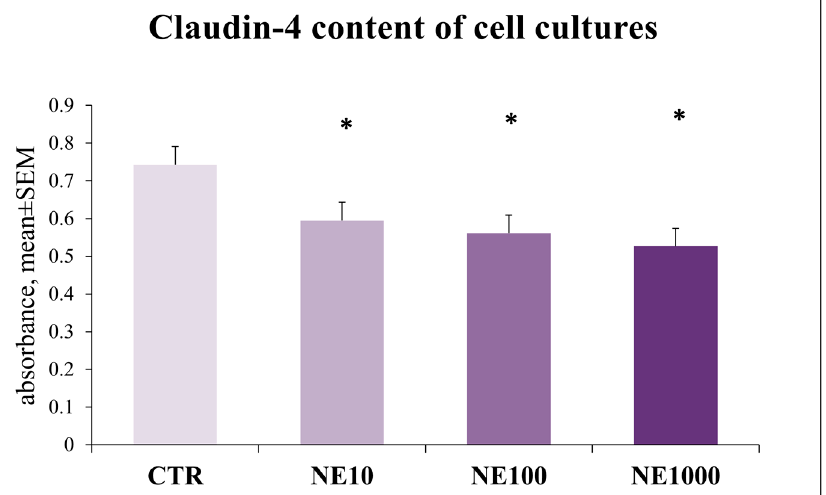
Figure 11. Claudin-4 content of uroepithelial cell culture after 1-h norepinephrine (NE) treatment. CTR = non-treated control cells, NE10 = 10 µM norepinephrine treated cells, NE100 = 100 µM norepinephrine treated cells, NE1000 = 1000 µM norepinephrine treated cells. n = 6/group, results are expressed as mean ± SEM, * p < 0.05 .